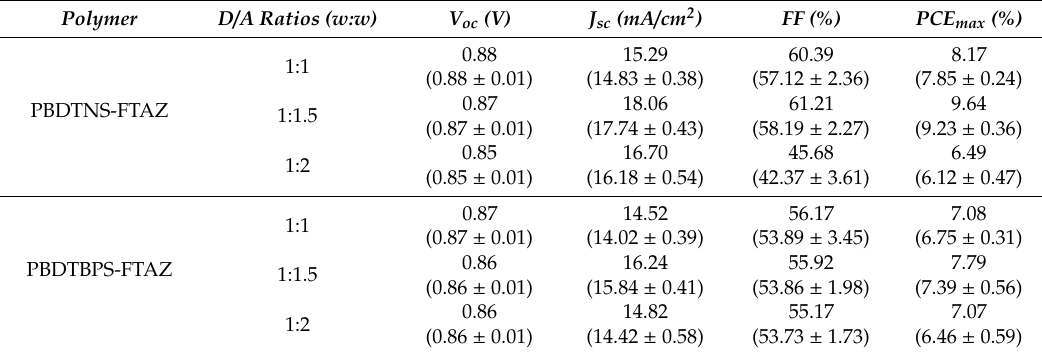
Figure 3. ( a ) Device structure, ( b ) cross-sectional SEM images of the device. J–V curves of ( c ) PBDTNS-FTAZ:ITIC and ( d ) PBDTBPS-FTAZ:ITIC PSCs with different D:A ratios. Table 1. Device parameters of PBDTNS-FTAZ and PBDTBPS-FTAZ with di ff erent polymer:ITIC (D:A)